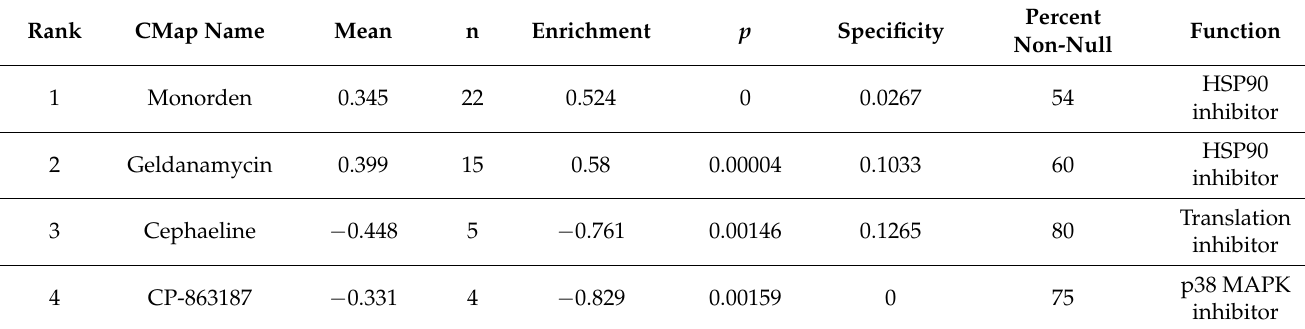
Table 2. The top 4 compounds were selected based on connectivity